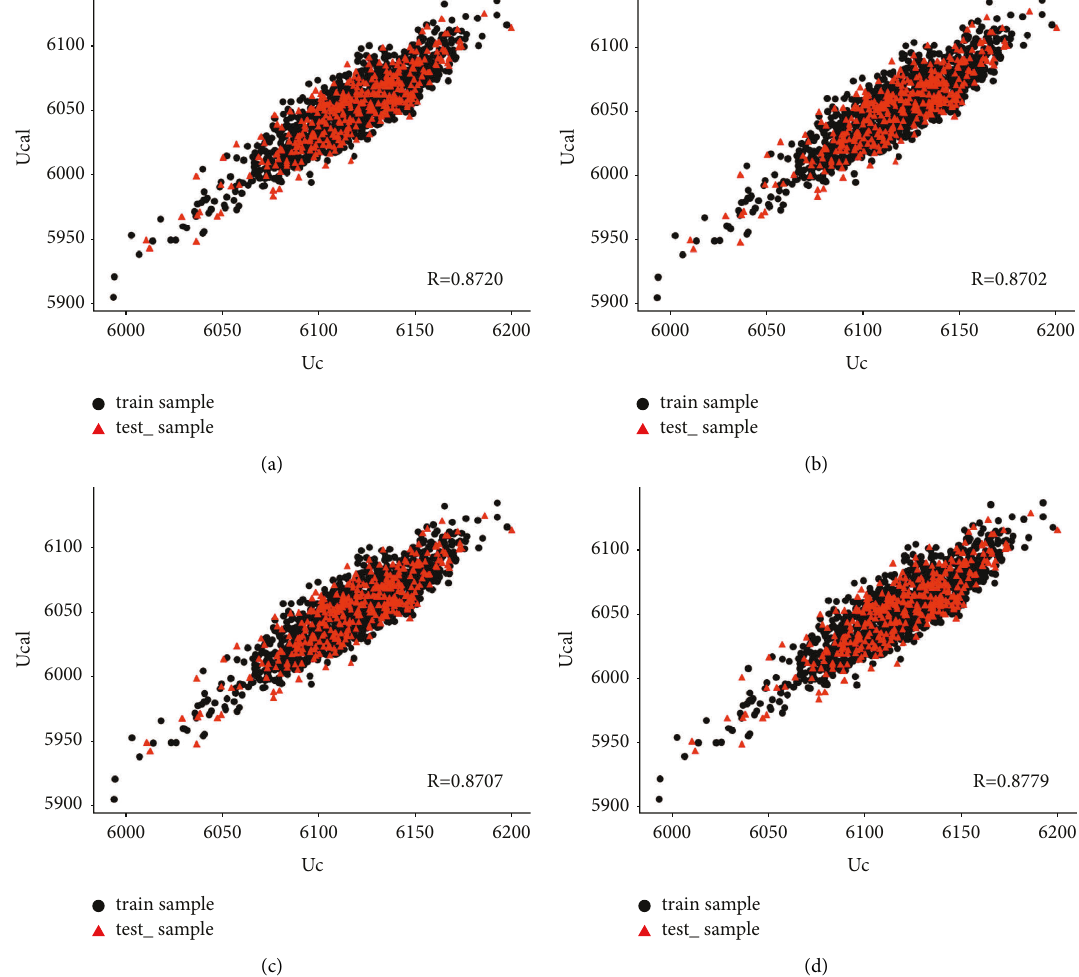
Figure 6: The scatter plot of U